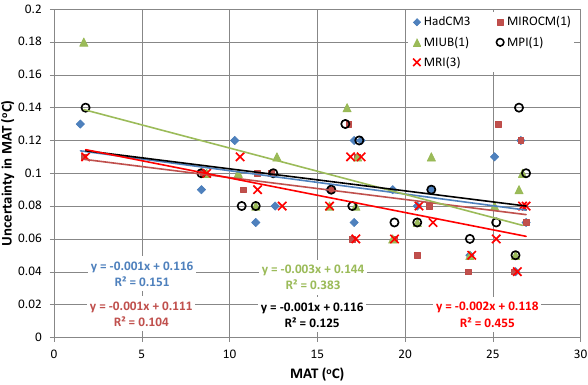
Figure 8. Within-GCM uncertainty ( ◦ C) in mean annual temper- ature versus mean annual temperature based on 100 replicates of monthly temperature (1965–1994, 20C3M) for five GCMs.